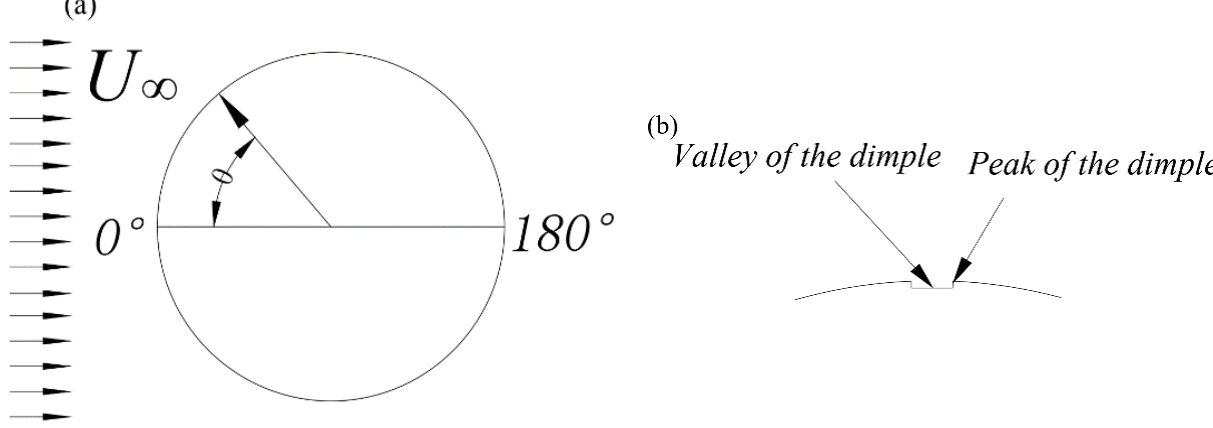
Figure 3. The schematic sketches: ( a ) Force coefficient monitoring angle; ( b ) Close-up of the dimple. Figures 4 and 5 expose the time-averaged skin friction coefficient C f ( Cf = τ ω /0.5 ρ U ∞ 2